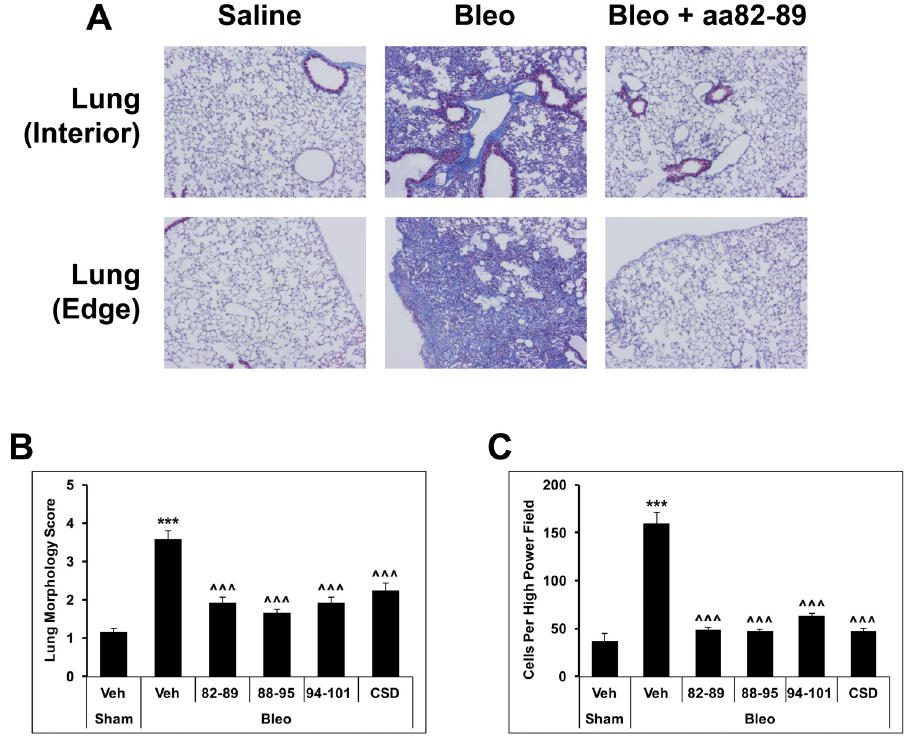
Fig 1. Inhibition of bleomycin-induced lung fibrosis and monocyte migration by subregions of CSD. A disease state similar to human SSc was induced by systemic treatment of mice with bleomycin [47]. Following removal of the bleomycin-containing pumps on day 8, treatment was initiated using pumps implanted subcutaneously loaded with 8 μ mol/kg of the indicated peptides that release their contents for 2 weeks. (A) Masson’s Trichrome-stained lung tissue sections demonstrate the massive fibrosis caused by bleomycin and its reversal by 82–89 both in the edge and interior of a lung lobe. (B) Tissue Morphology in Masson’s Trichrome-stained tissue sections was quantified as described [16, 49]. (n = 6 per group) (C) Monocyte migration in vitro was quantified as described [21] using BM monocytes isolated from mice treated in vivo both with bleomycin and with peptides as indicated. (n = 4 per group) ��� p < 0.001 vs Sham control; ^^^ p < 0.001 vs Bleo